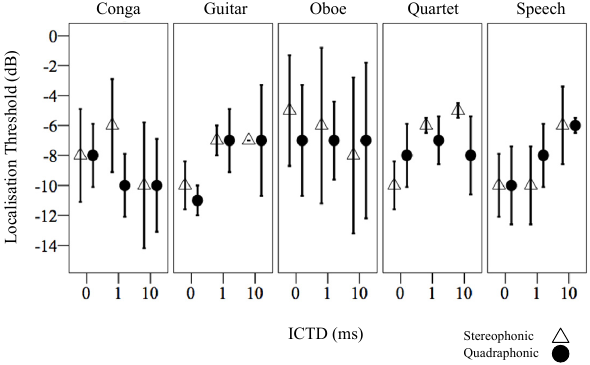
Figure 4. Medians and associated notch edges for each experimental condition. ICTD: interchannel time difference.